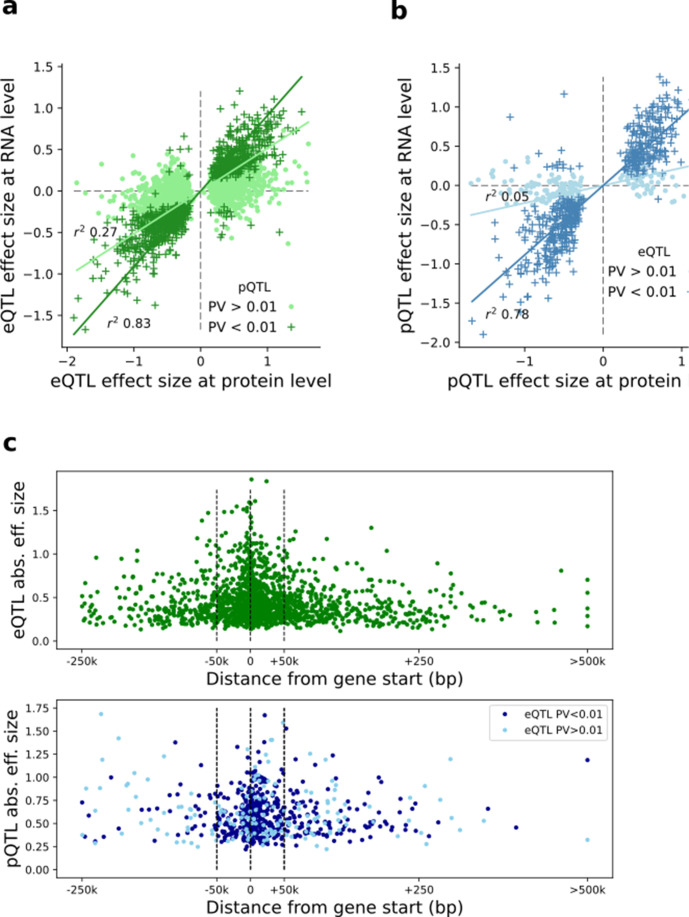
Comparison of eQTL and pQTL effect sizes and genomic positions.(a) Scatter plot of QTL effect size estimates for eQTL lead variants (FDR < 0.1) at the RNA and protein level, respectively. Dark green denotes eQTLs nominally significant at pQTL; Light green denotes eQTLs lacking protein replication. (b) Scatter plot of QTL effect size estimates for lead pQTL variants (FDR < 0.1) at the protein and RNA level, respectively. Dark blue denotes pQTLs nominally significant at eQTL; Light blue denotes pQTLs lacking eQTL replication. (c) Distribution of eQTL(top) and pQTL (bottom) around the gene start. Y-axis indicates the QTL effect size. pQTLs are stratified by eQTL replication status.